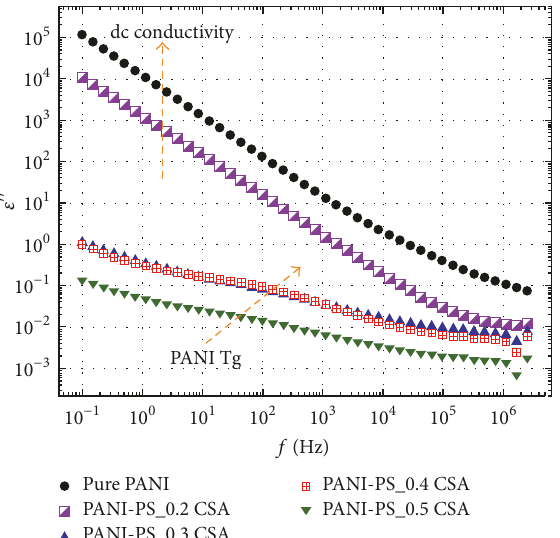
Figure3: 𝜀 󸀠󸀠 versus 𝑓 at20 ∘ CforthepurePANIandPANI-PSblends containing variable CSA concentrations.